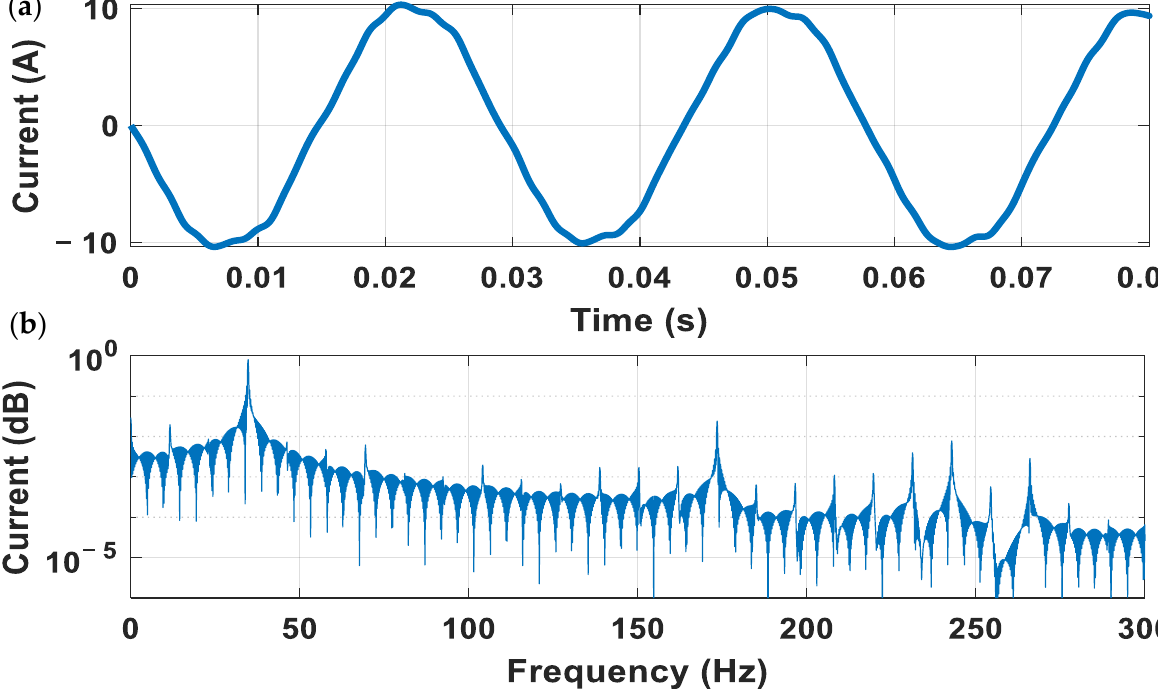
Figure 11. Decomposed signal below 630 Hz. ( a ) Time-domain signal, ( b ) Fourier transform of the signal. The spectrum analysis in Figure 11b shows that the main frequency component is 34.7 Hz. It can also be verified from the time-domain signals, as Figure 11a indicates